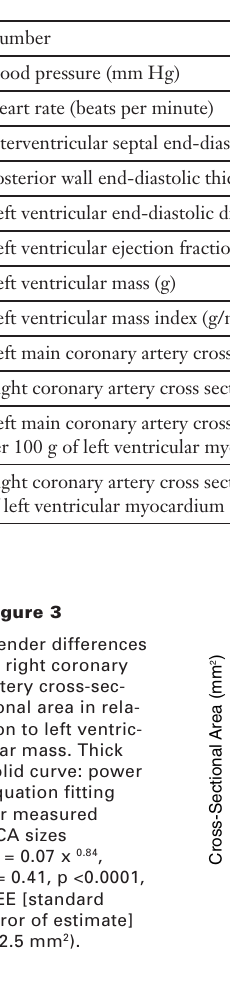
Gender differences of left main coronary artery cross-sec- tional area (vertical axis) in relation to left ventricular mass (horizontal axis). Thin solid curve: theoretically expected left coronary artery caliber according to the law of mini- mum viscous energy loss for the transport of blood in the coronary circulation (y = 0.40 x 0.67 ). Thick solid curve: power equation fitting to compare measurements in all study indi- viduals with theroretically expected left coronary artery size